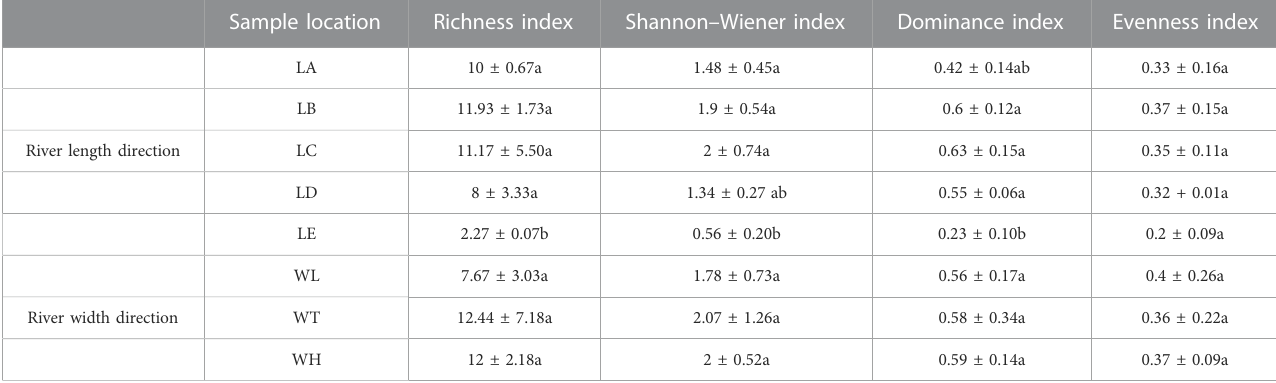
TABLE 2 Plant species diversity index of the wetlands in the riparian zone of the Ulgai